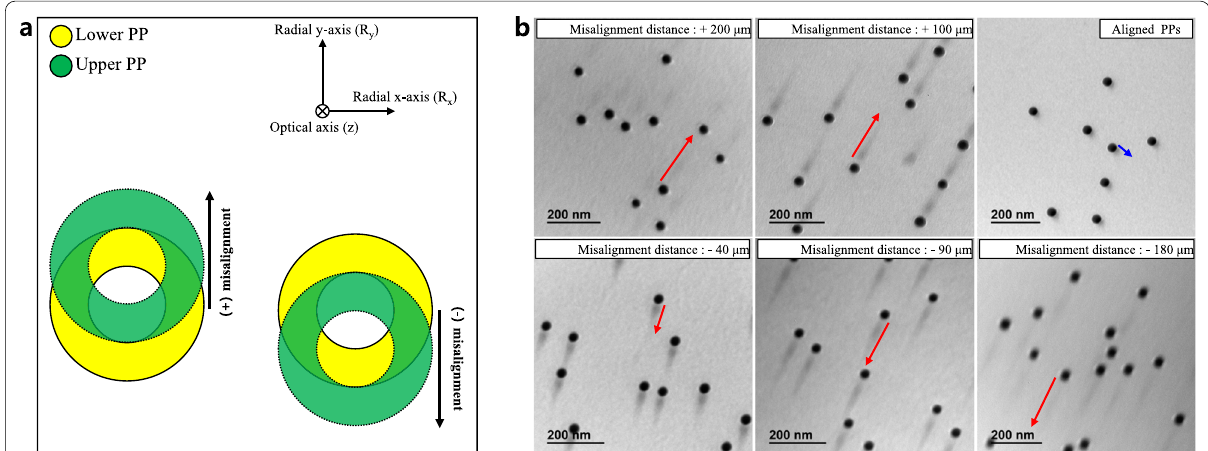
Fig. 4 Adjusting of mechanical alignment of OL P/Ps and thus shadow contrast imaging of AuNPs. a Schematic diagram of the mechanical alignment of OL P/Ps. b Shadow contrast imaging of AuNPs according to the magnitude of mechanical misalignment of OL P/Ps. The length and direction of shadow contrast (red arrows) are proportional and considered to the magnitude and direction of OL P/Ps misalignment,